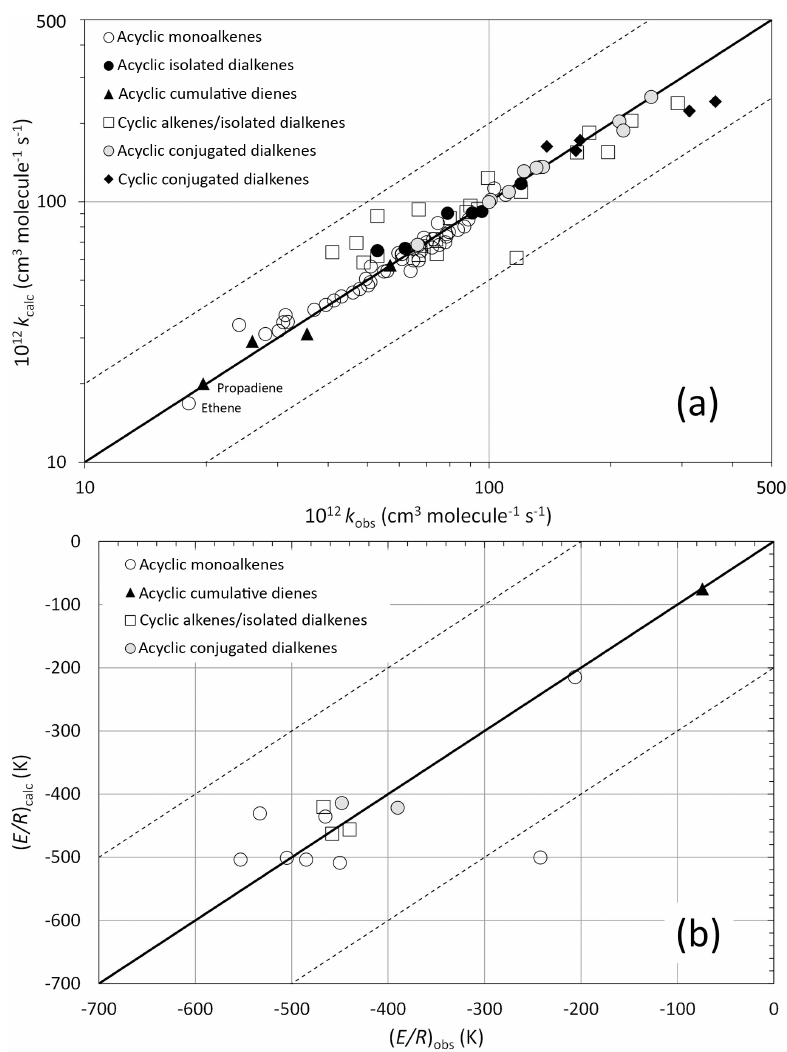
Figure 6. (a) A log–log correlation of k calc and k obs at 298K for alkenes (for presentation purposes, the values for ethene and propadiene have been scaled up by a factor of 2). The broken lines show the factor of 2 range. (b) A correlation of the temperature coefficients (E/R) calc and (E/R) obs for the same compound classes. The broken lines show the ± 200K